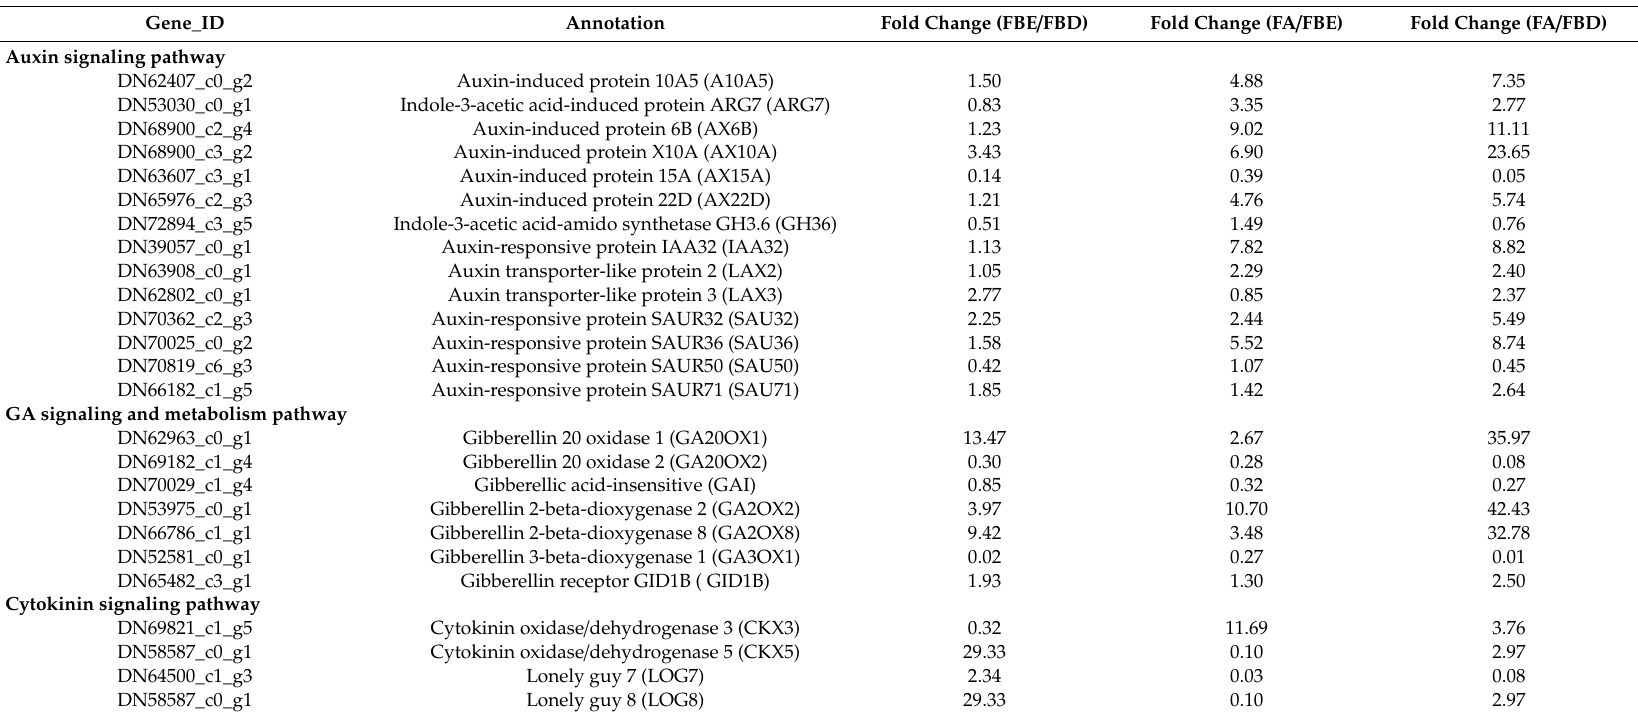
Table 1. Di ff erentially expressed genes (DEGs) involved in the signaling pathways of auxin, GA, and